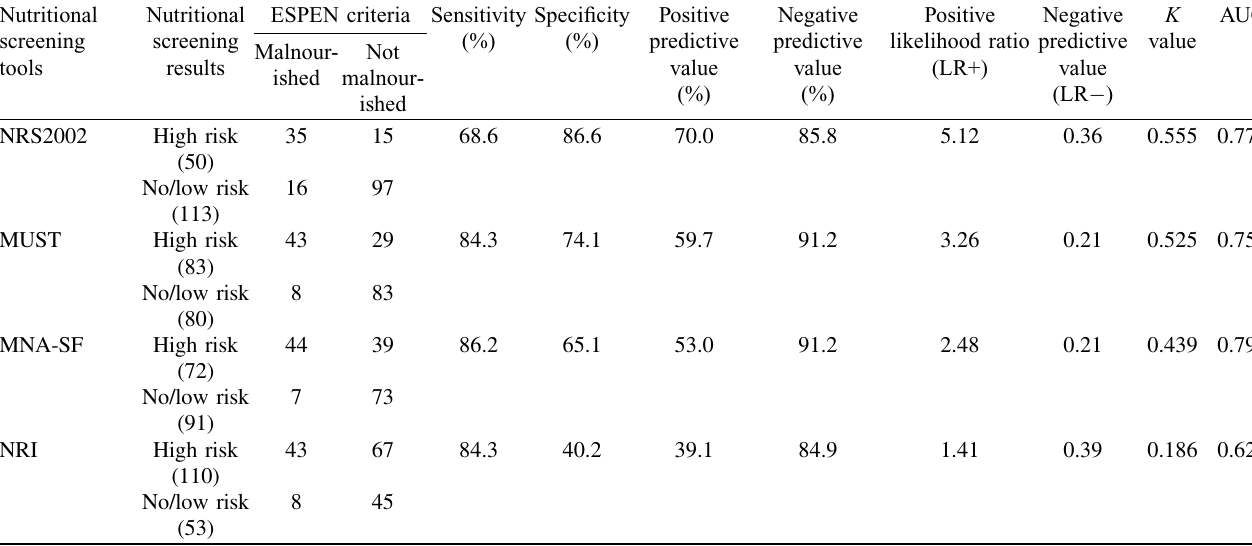
Table 6. Comparison of four screening tools for malnutrition with ESPEN diagnostic criteria in alveolar echinococcosis patients. Nutritional screening tools